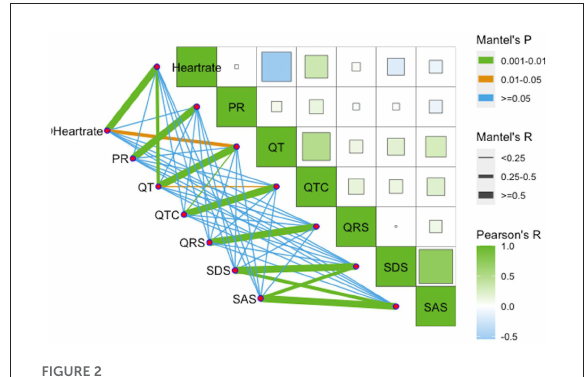
FIGURE2 Correlation between ECG measures and psychological